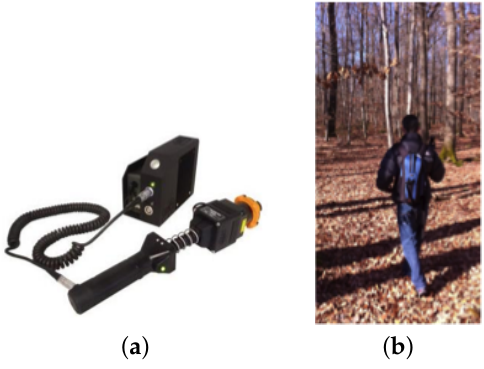
Figure 2. ( a ) The Zebedee ZEB-1 handheld mapping system; ( b ) An operator holding the device moving through the Forêt de Tronçais,